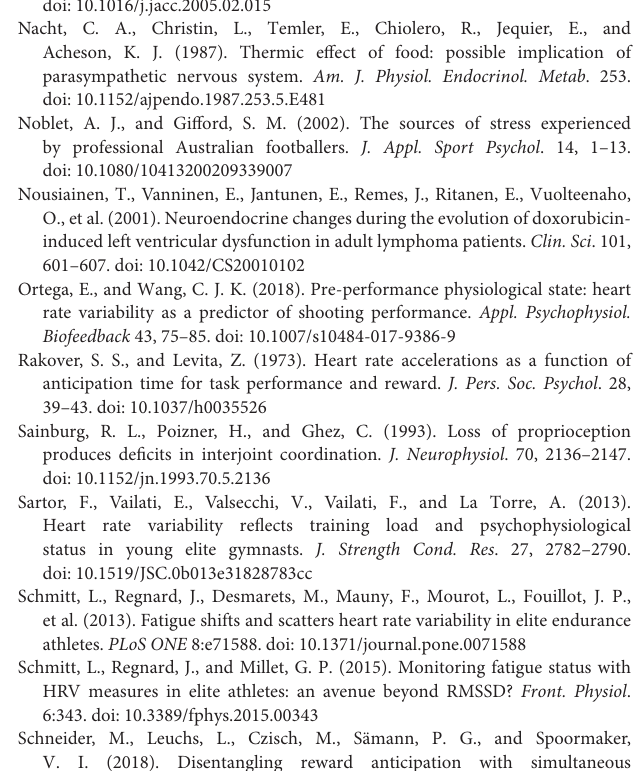
athletes. PLoS ONE 8:e71588. doi: 10.1371/journal.pone.0071588 Schmitt, L., Regnard, J., and Millet, G. P. (2015). Monitoring fatigue status